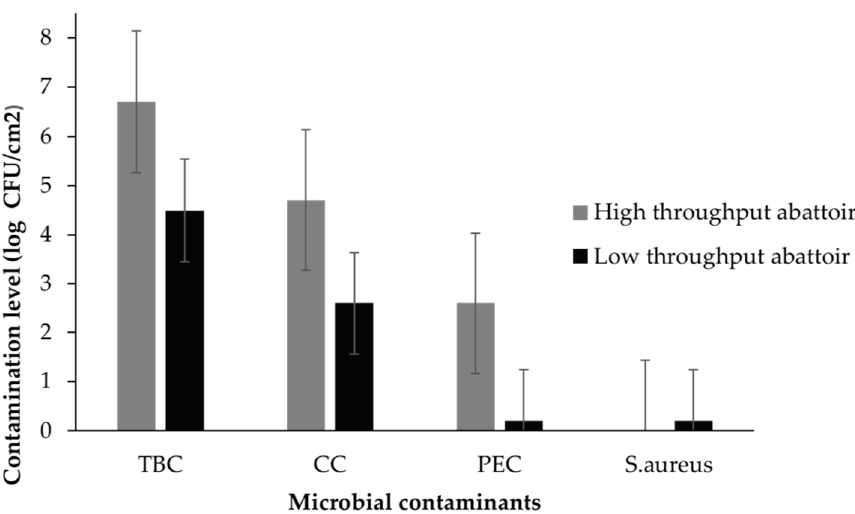
Figure 1. Contamination levels in beef, pork and mutton carcasses in a commercial and a communal abattoir (TBC = total bacteria count; CC = coliform count; PEC = presumptive E. coli ) (n = 108). Error bars indicate average ± standard deviation of meat microbial